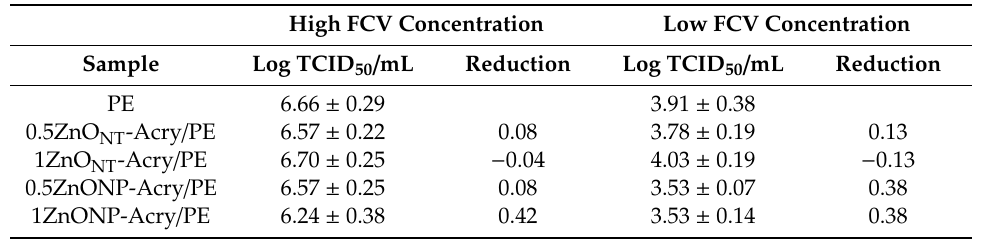
Table 2. Antiviral e ff ect of ZnO films on feline calicivirus (FCV) titers (log TCID 50 / mL) after